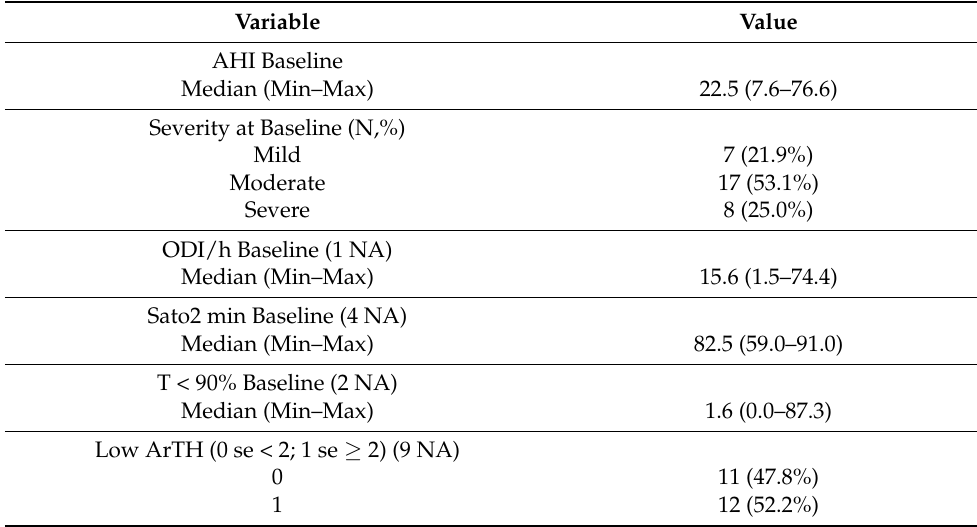
Table 2. Baseline nocturnal cardiorespiratory monitoring data.